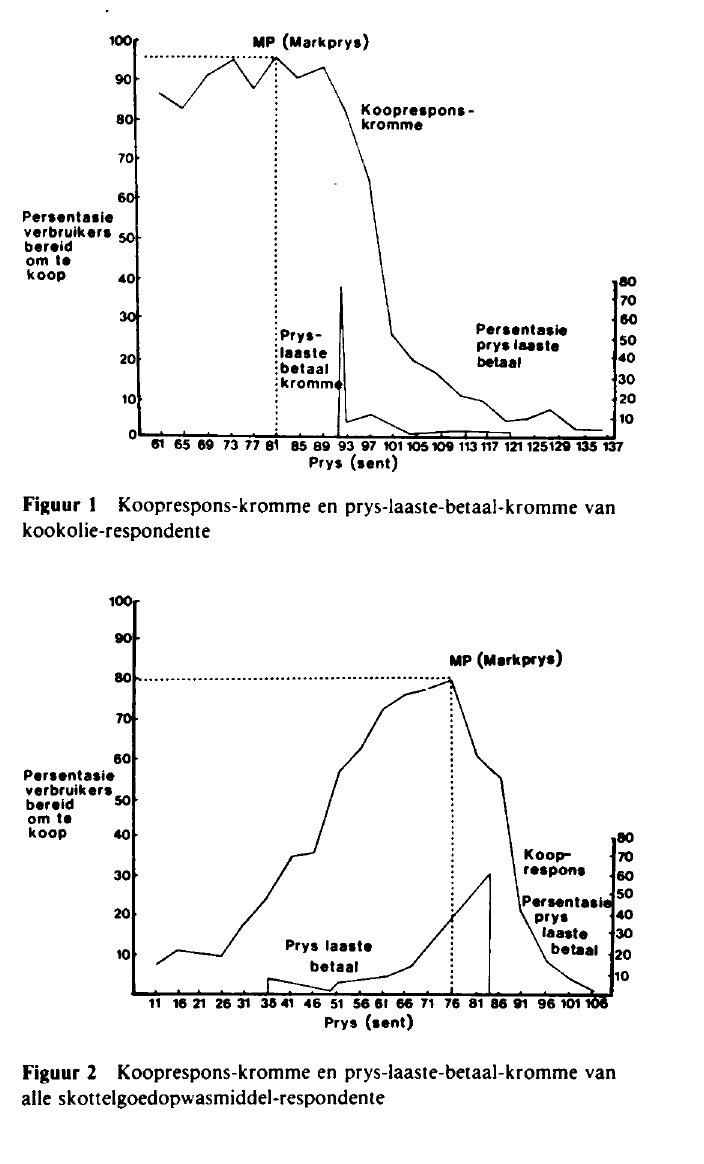
Figuur 2 Kooprespons-kromme en prys-laaste-betaal-kromme van alle